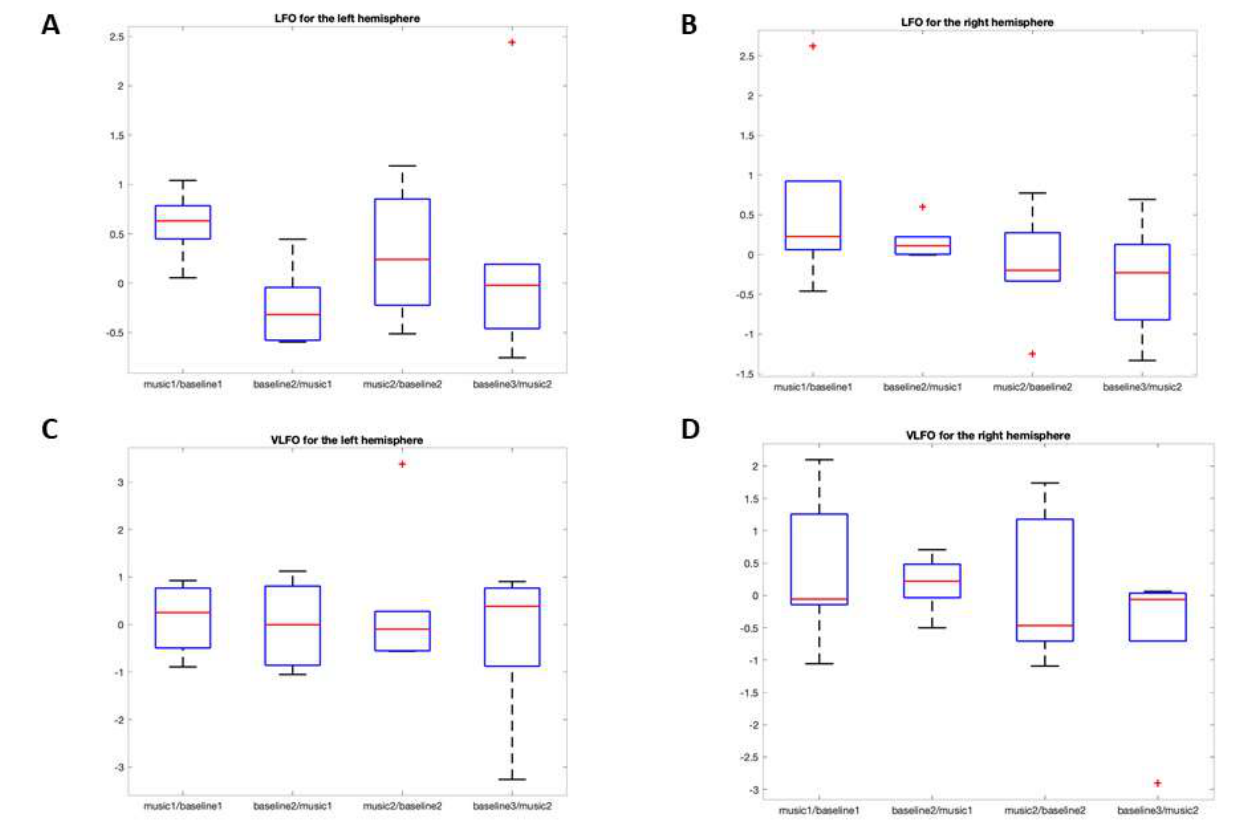
Figure A3. Boxplot showing, on the y -axis, the ratio of LFO power (low-frequency oscillation) and VLFO power (very-low-frequency oscillation) for O2HB calculated using an alternative cut-off of 0.03 Hz between LFO and VLFO; the same pattern of variations already observed with the cut-off of 0.04 Hz can be observed with this alternative cut-off. On the x -axis, the subsequent experimental blocks are shown: (m1/b1) from the first baseline to the first music period; (b2/m1) from the first music period to the second baseline; (b2/m2) from the second baseline to the second music block; (b3/m2) from the second music block to the third baseline. ( A ) Ratios of LFO power in the left hemisphere. After an increase in LFO power in m1/b1, a significant decrease is shown in b2/m1. ( B ) Ratios of LFO power in the right hemisphere. ( C ) Ratios of VLFO power in the left hemisphere. ( D ) Ratios of VLFO power in the right hemisphere.